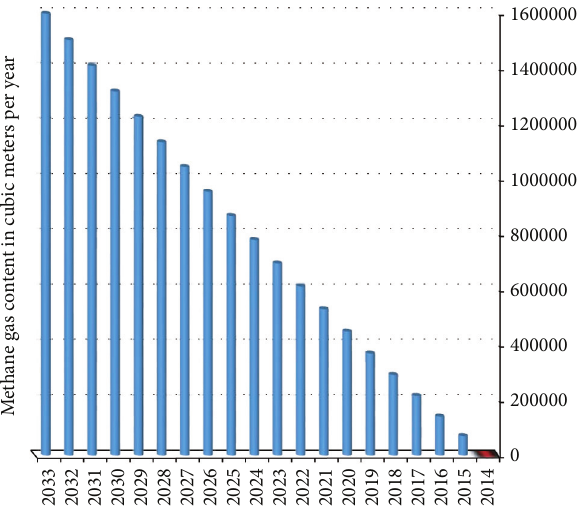
Figure 3: Methane gas content in cubic meters per year.